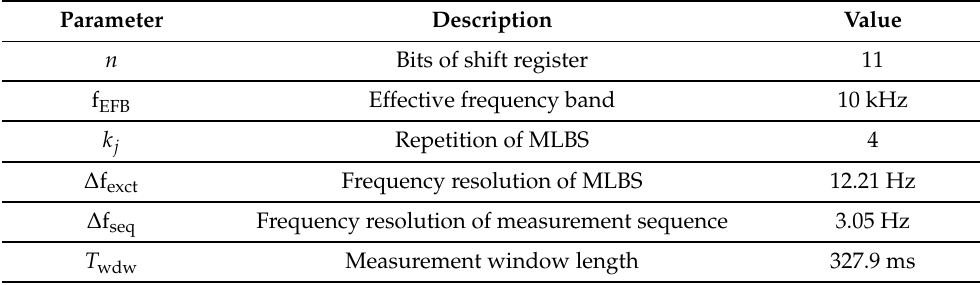
Table 1. Parameters of excitation sequence.